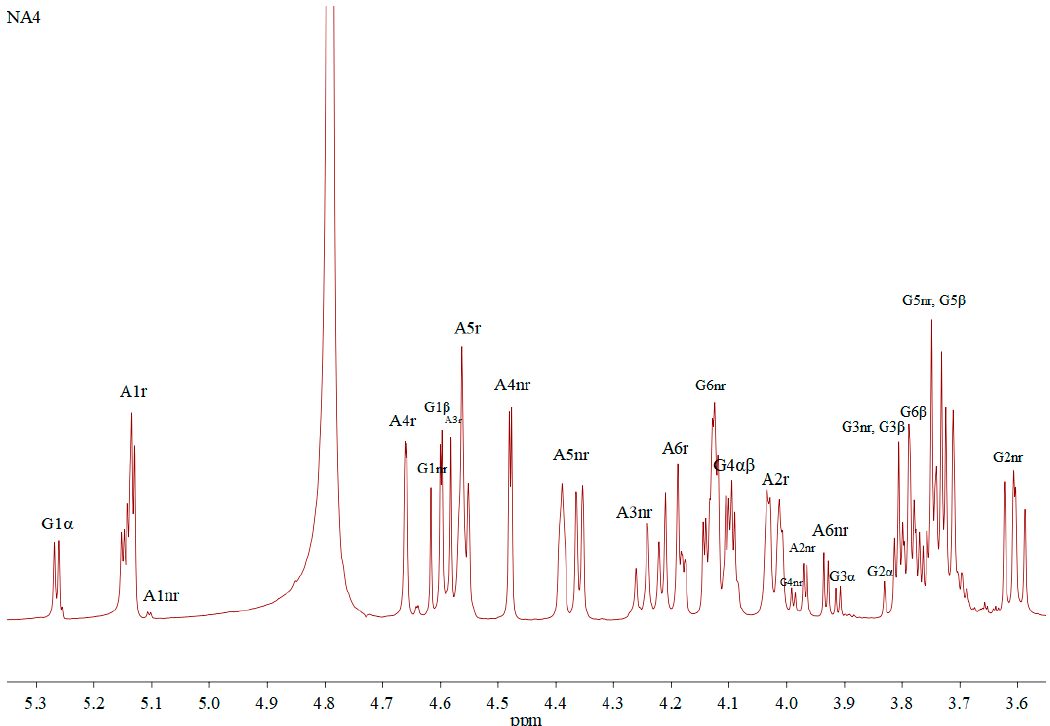
Figure 8. 1 H NMR spectra of NA4, Peak labels: A, 3,6 anhydrogalactose; G, galactose; nr and r refer to the non-reducing and reducing ends; α , β refer to positions of protons on reducing ends; numbers from 1 to 6 refer to place of protons.